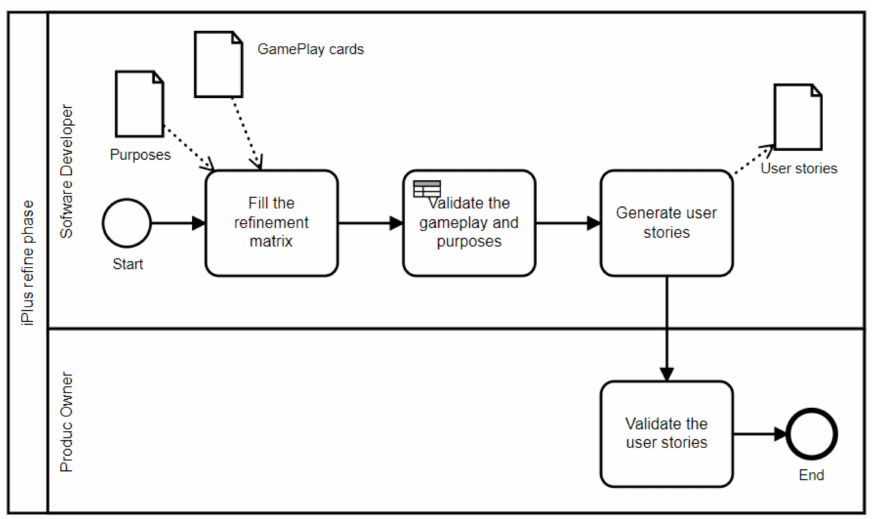
Figure 8. Refine Phase